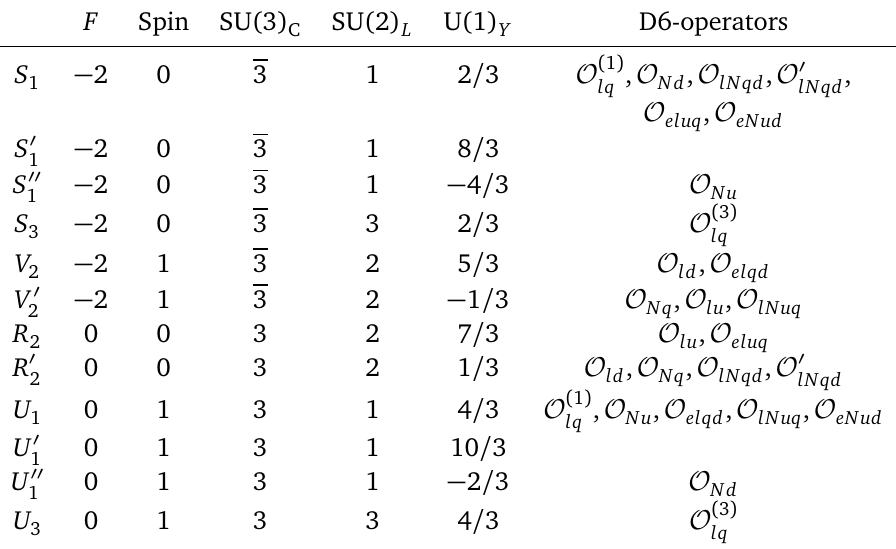
Table 3: Leptoquarks that can couple to SM particles and right-handed neutrino sin- glets, together with the operators of Table 1 they can generate [ 35 ] . Our convention + Y / 2. The cases considered here are S (cid:48)(cid:48) is Q = I 3 interactions of our DM fermion N with right-handed up- or